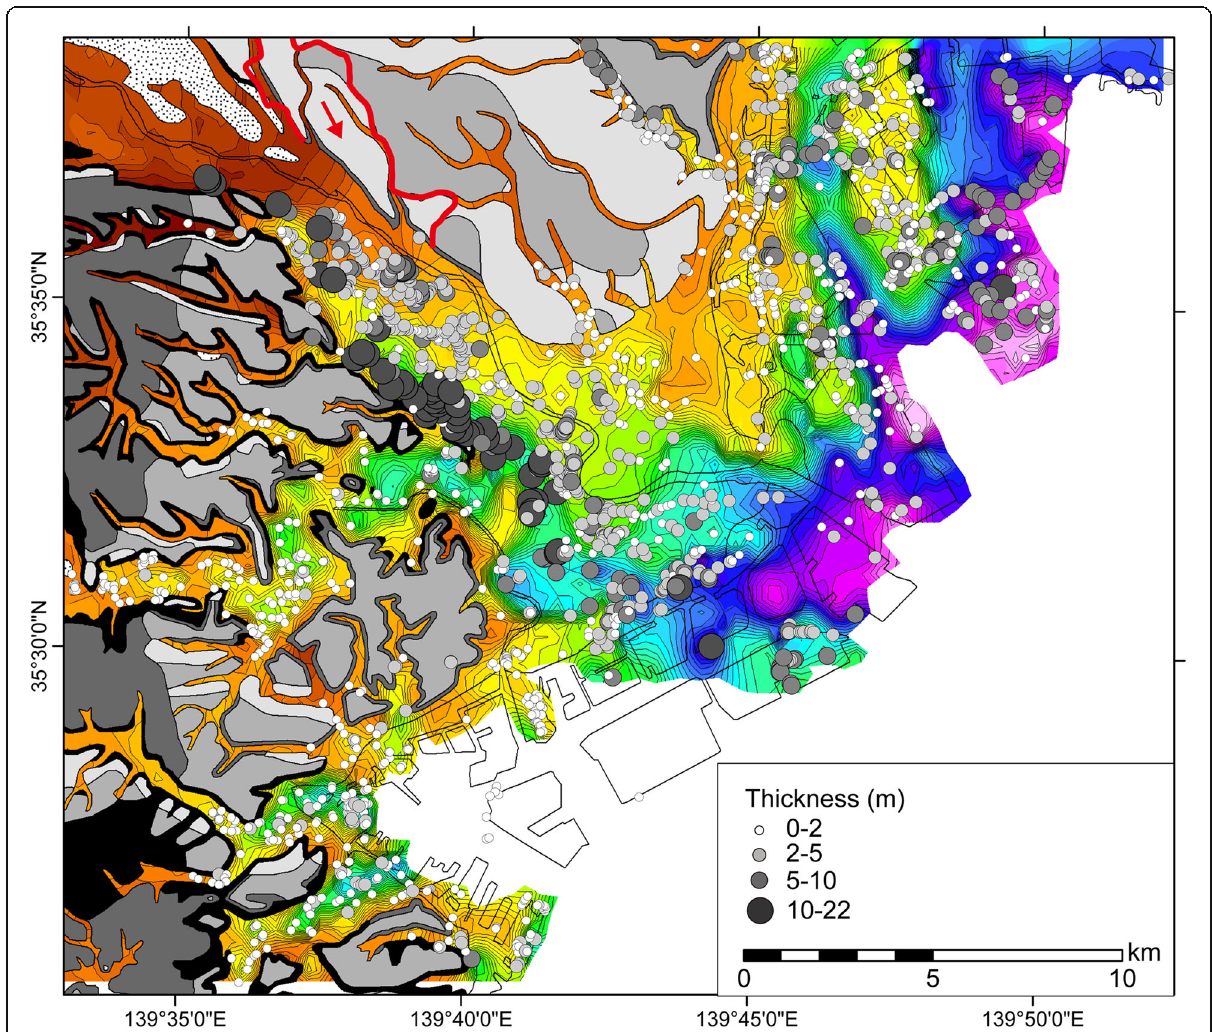
Fig. 10 Distribution of the thickness of the gravel bed at the base of the post-LGM incised-valley fills, plotted on the elevation map of Fig. 7. Thick gravel beds are found along the Tama